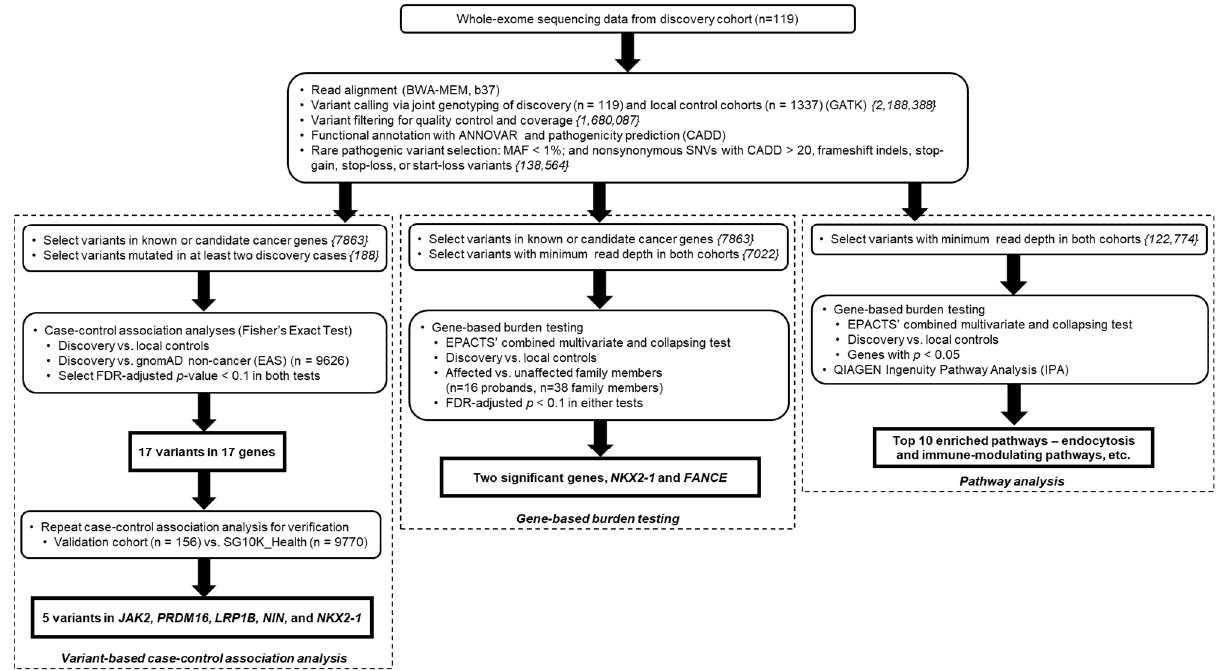
Figure 1. Study design and steps taken for the selection of candidate NPC susceptibility variants. For each variant filtering step, the number of variants remaining after filtering is given within the curly brackets.